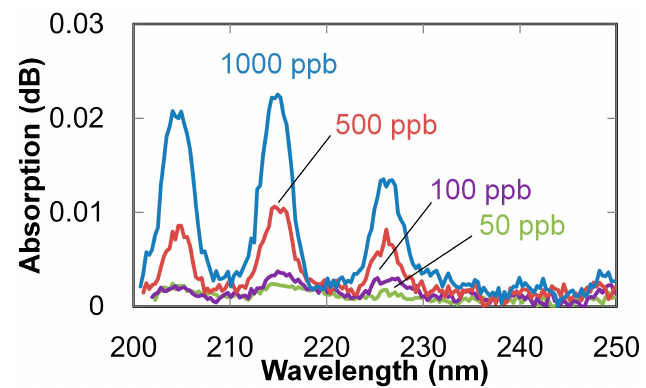
Figure 5. Absorption spectra of NO gases with different concentrations measured with 3 m hollow optical fiber and LDLS.